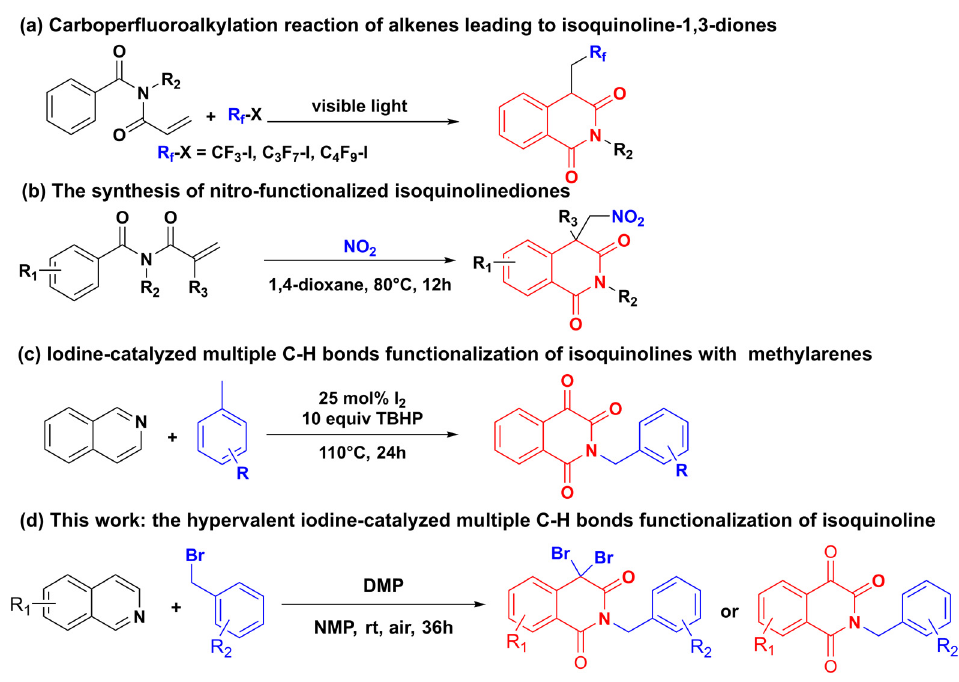
Figure 2. Various synthetic routes for isoquinolinone derivatives.